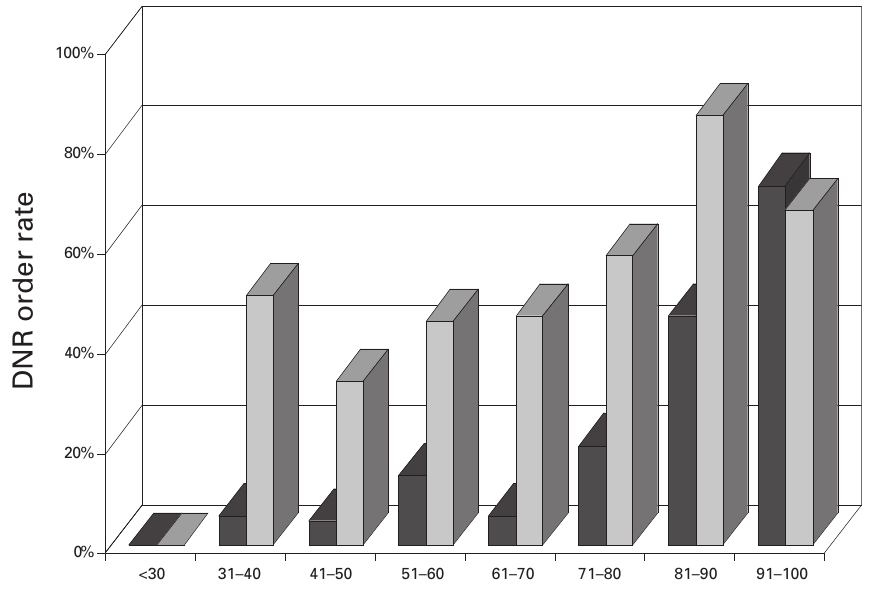
Frequency of DNR orders as a function